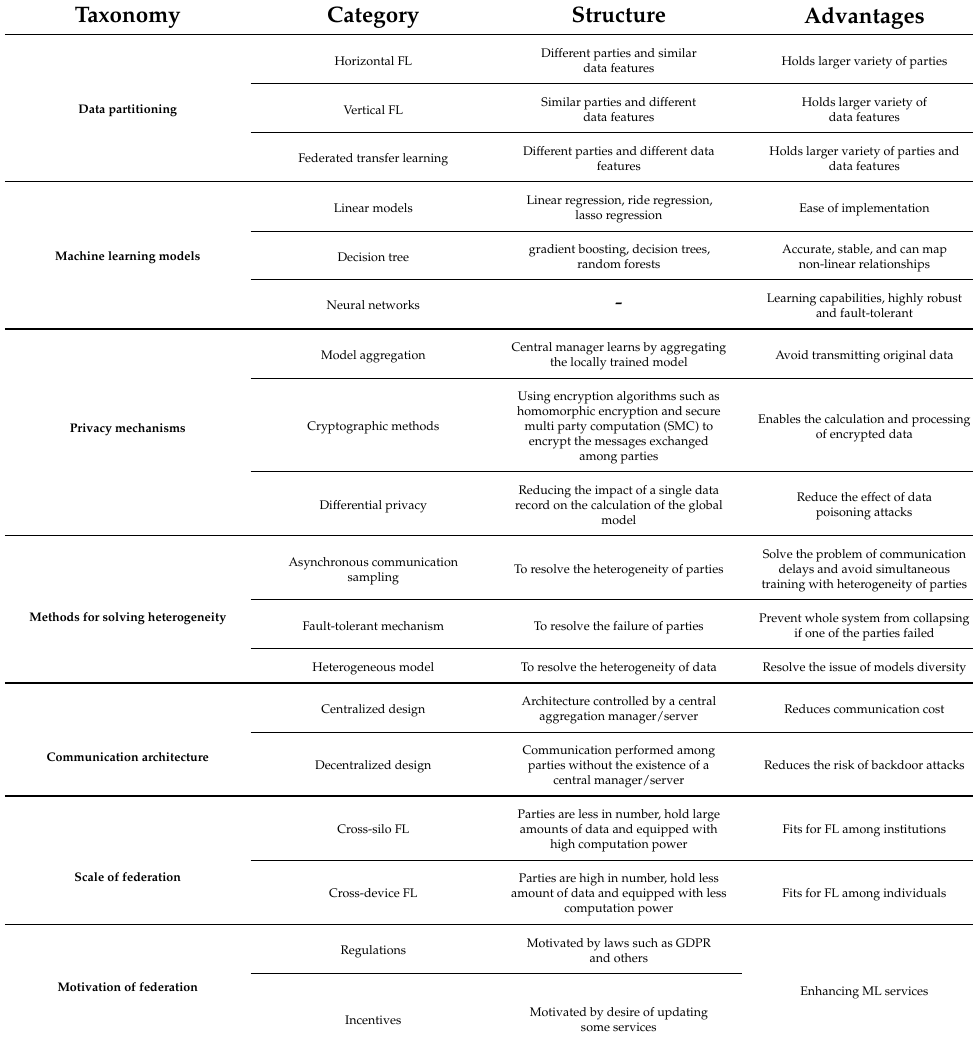
Table 2. Summarized Taxonomy for Federated Learning